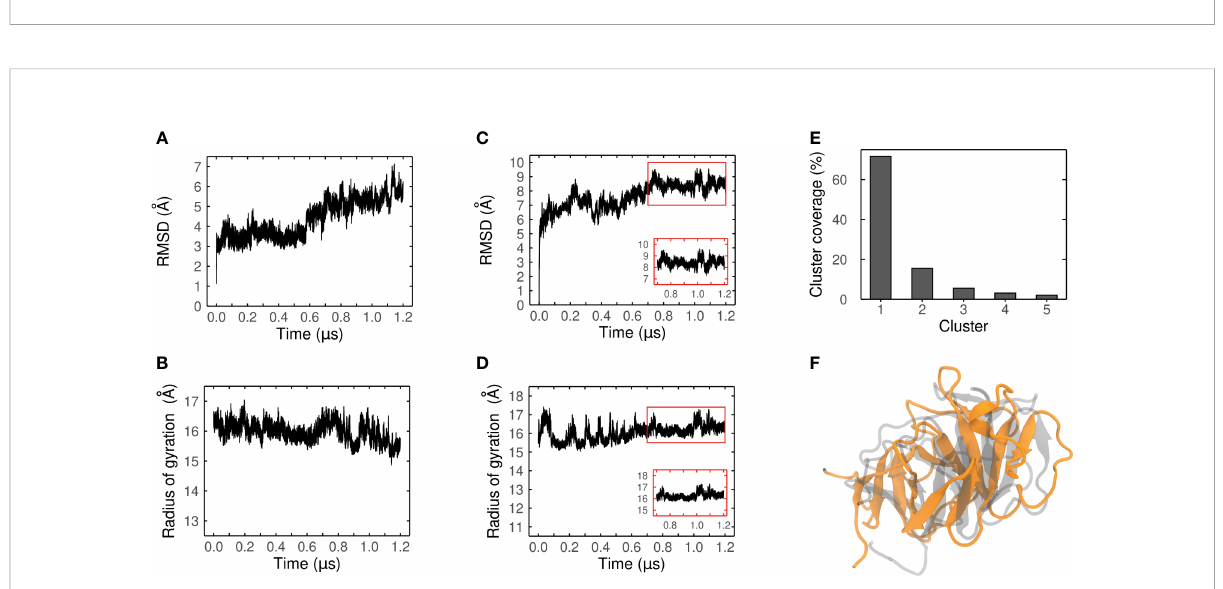
FIGURE 6 Convergence analysis of the MD simulation. Ca-RMSD values and radius of gyration (Rg) of MEP_6 (A, B) and MEP_12 (C, D) during a simulation of 1.2 m s. Inset plots in (C, D) show the last 500 ns where the RMSD and Rg converged. (E) Coverage (%) of the fi ve most populated clusters obtained from the RMDS-based clustering. (F) Structural alignment between the AlphaFold2 model (gray) and the centroid of the most populated cluster (in orange) of MEP_12.